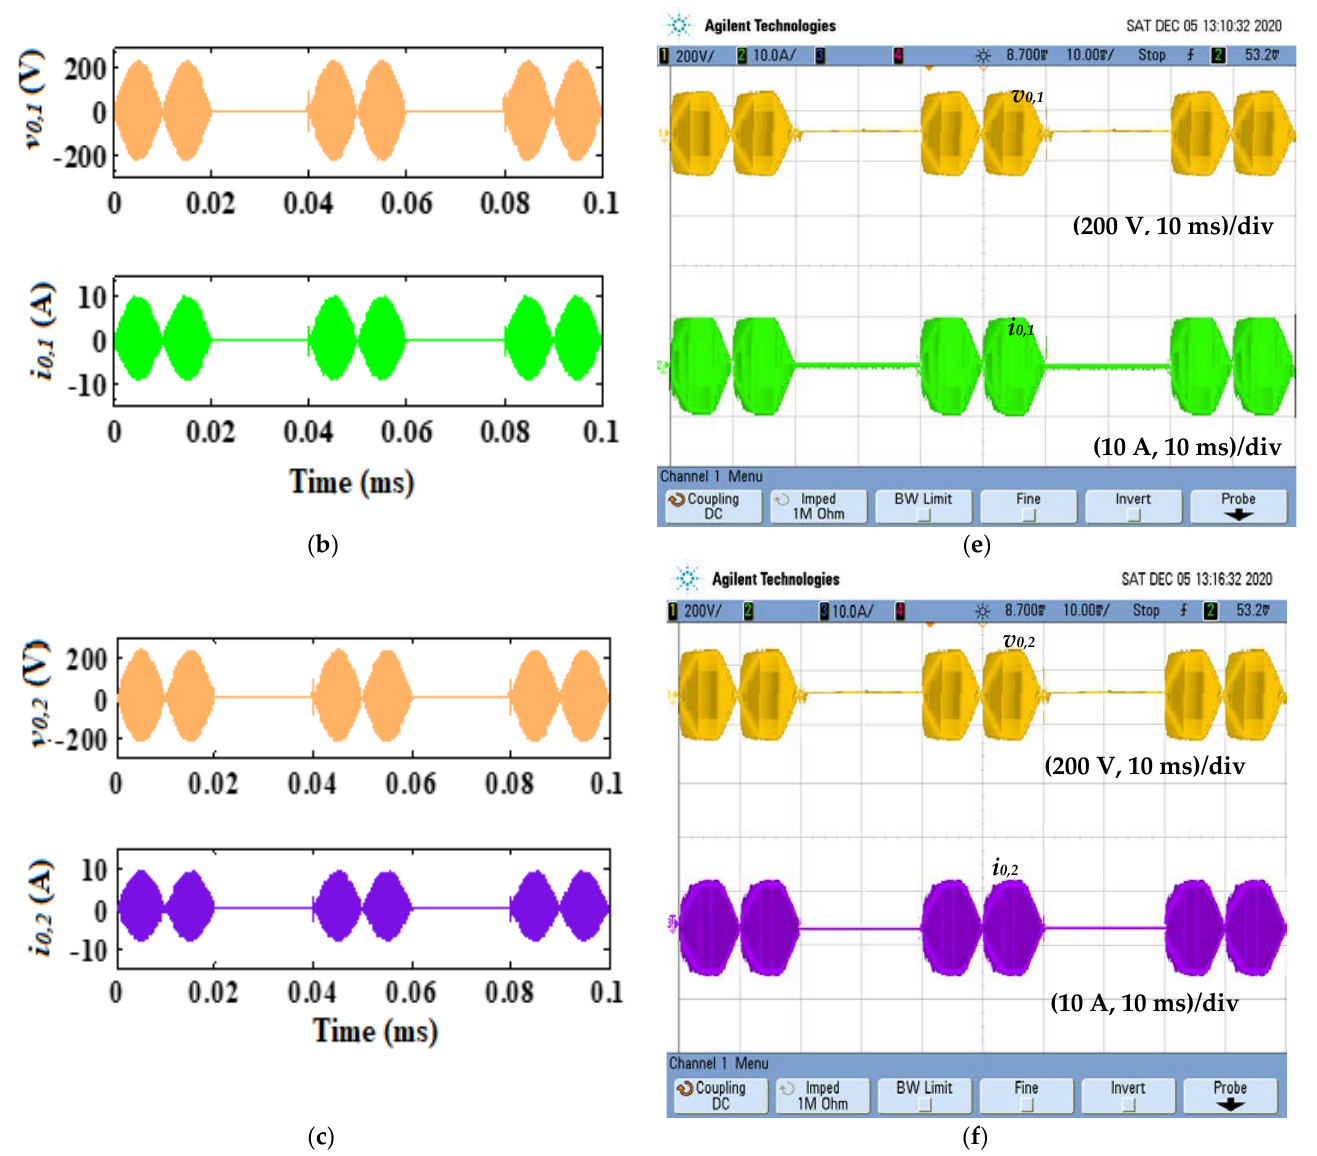
Figure 8. Main waveforms for 50% D PDM : simulation waveforms ( a ) switching pulses, ( b ) output voltage and current of load 1, ( c ) output voltage and current of load 2, experimental waveforms ( d ) switching pulses, ( e ) output voltage and current of load 1, ( f ) output voltage and current of load 2.